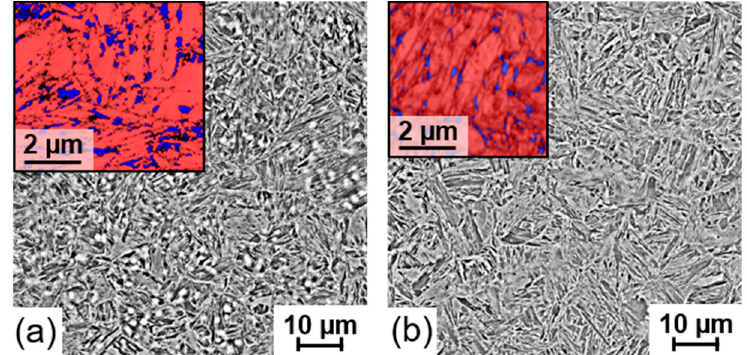
Figure 11. SEM micrographs of Q&P-A samples base material ( a ) and weld junction ( b ), inserts show results of EBSD analyses with bcc/martensite (red) and fcc austenite (blue) crystal structure and microstructure.